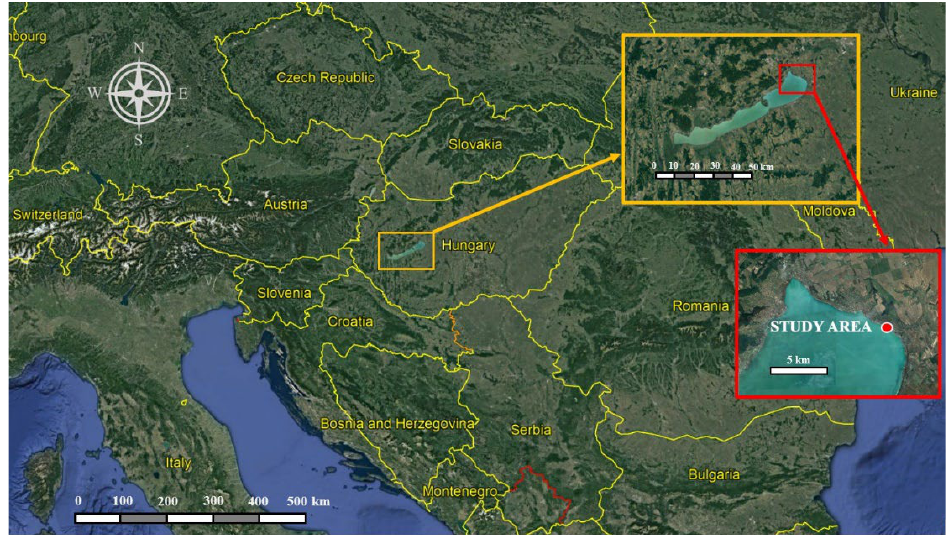
Figure 1. The location of the study area (Google Earth Pro Application).